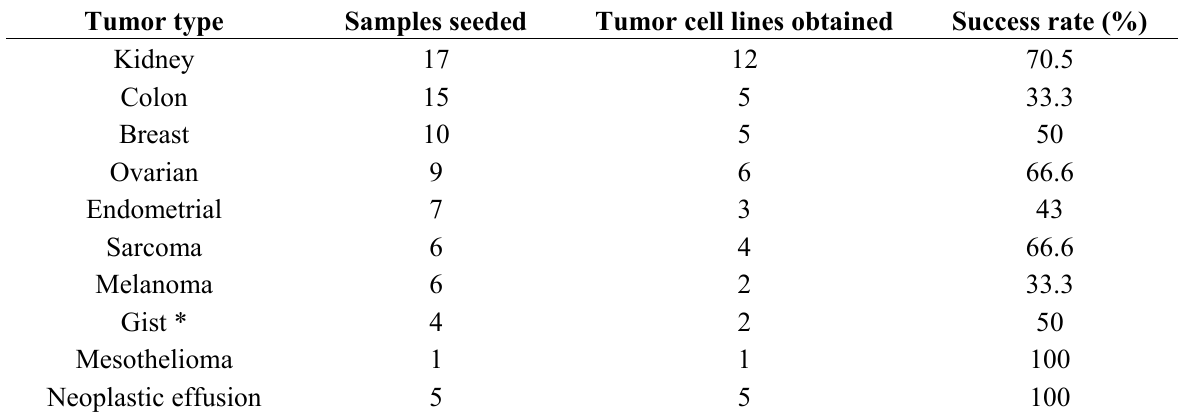
Table 1. Primary cultures from solid tumors disaggregated with cell scraper.